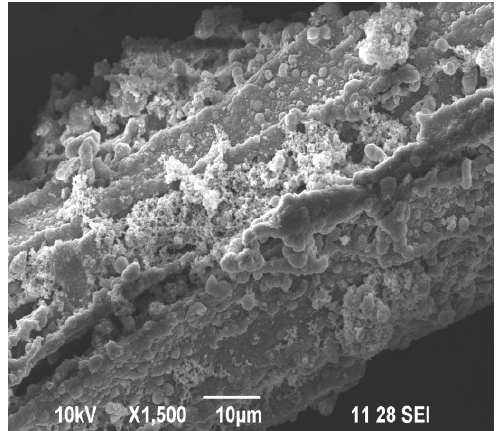
Figure 1 . SEM image of PPC.